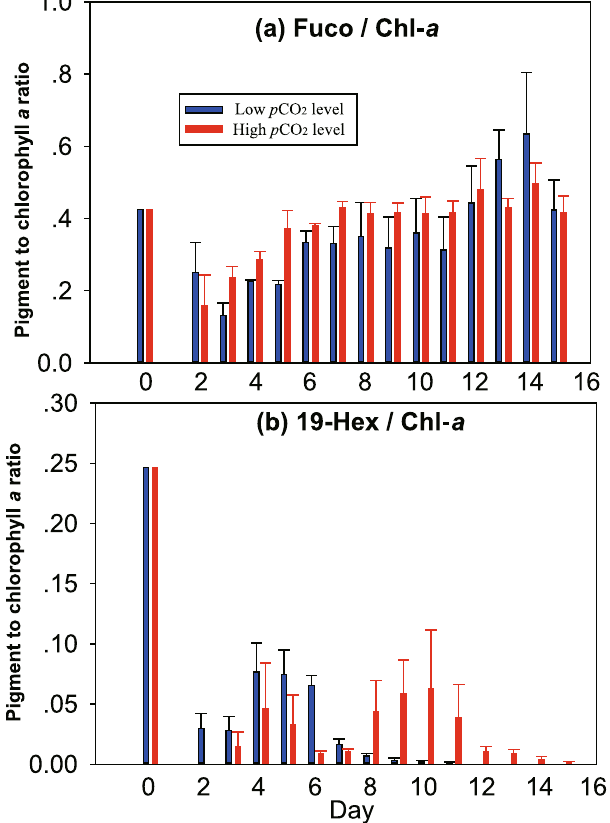
Figure 7. Temporal variations in ratios of fucoxanthin ( a , Fuco) and 19 ′ hexanoyl-oxy-fucoxanthin ( b , Hex- Fuco) to chlorophyll a in 6 seawater enclosures which were perturbed by bubbling with ambient air (400 ppmv CO 2 , Low CO 2 level) or an air/CO 2 mixture at a concentration of 1000 ppmv CO 2 (High CO 2 level). Columns are the means and error bars are the standard errors of three replicate enclosures.